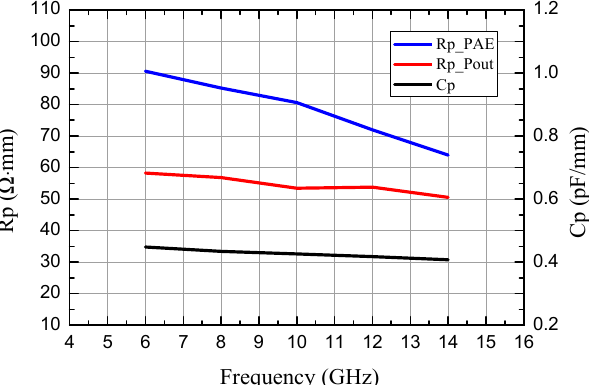
Figure 2. The R p and C p parameters versus frequency.